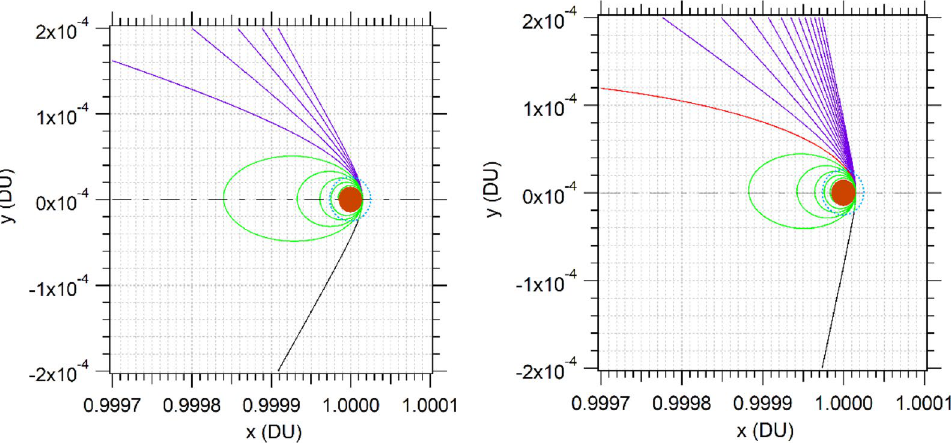
Figure 2. Trajectories in the synodic frame with V P = 0.246 VU (left) and 0.336 VU